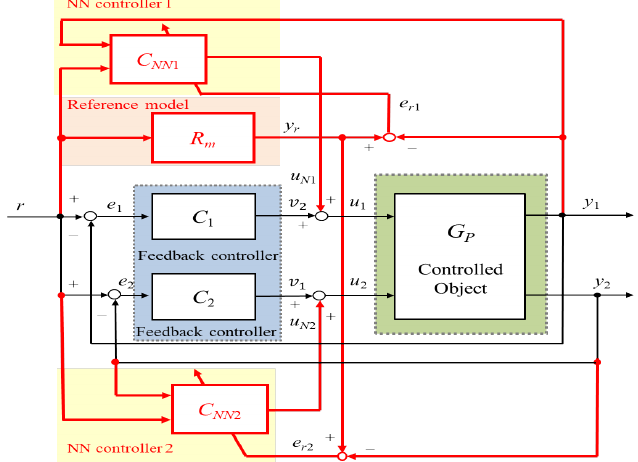
Figure 1. Block diagram of the multi-input multi-output (MIMO) temperature control